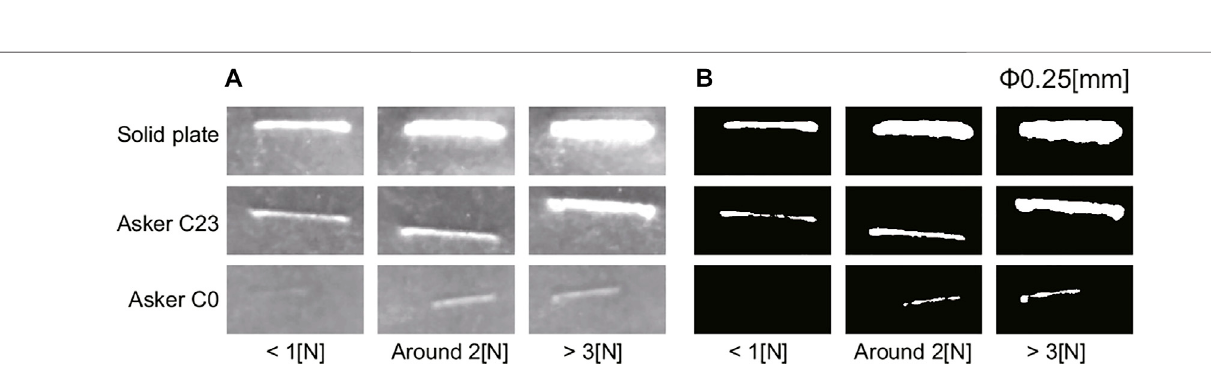
Frontiers in Robotics and AI |